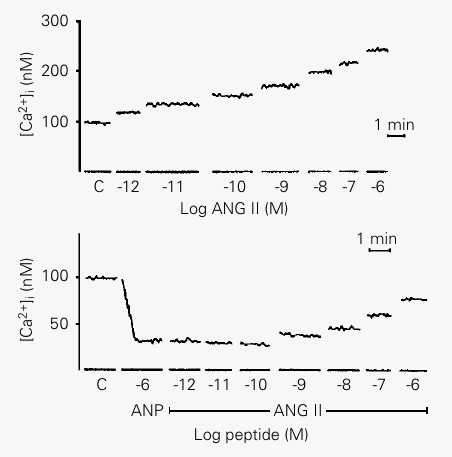
Figure 5 - Cell calcium levels in MDCK cells subjected to in- creasing angiotensin II (ANG II) concentrations (upper panel) alone or in the presence of atrial natriuretic peptide (ANP, 1 (cid:181)M; lower panel). Data from Ref. 20, with